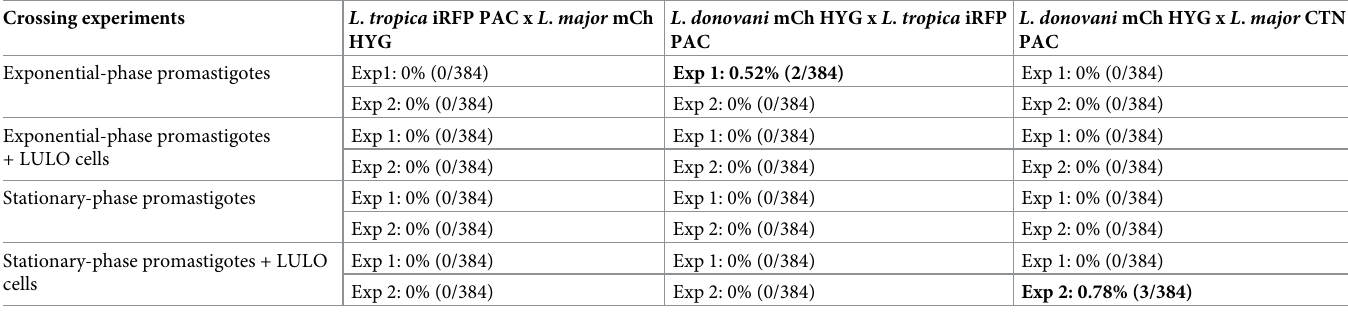
Table 4. Interspecies crossings performed with L . donovani , L . major and L . tropica , and the success rate (percentage of hybrids obtained) using different mating parental lines, different promastigote stages and in the presence and absence of LULO cells. Crossing